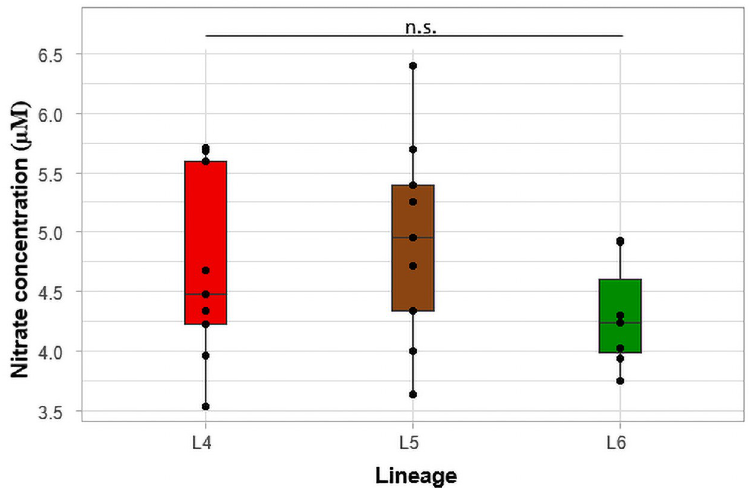
Fig 6. Comparison of nitrate concentration. The individual isolates are represented by the black points in the boxplot.